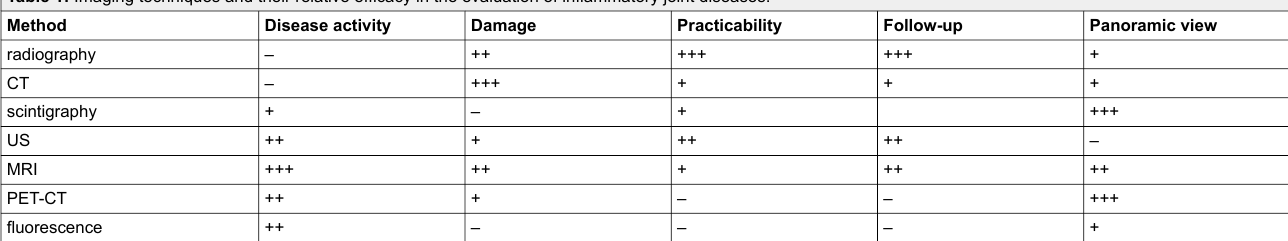
Table 1: Imaging techniques and their relative efficacy in the evaluation of inflammatory joint diseases.